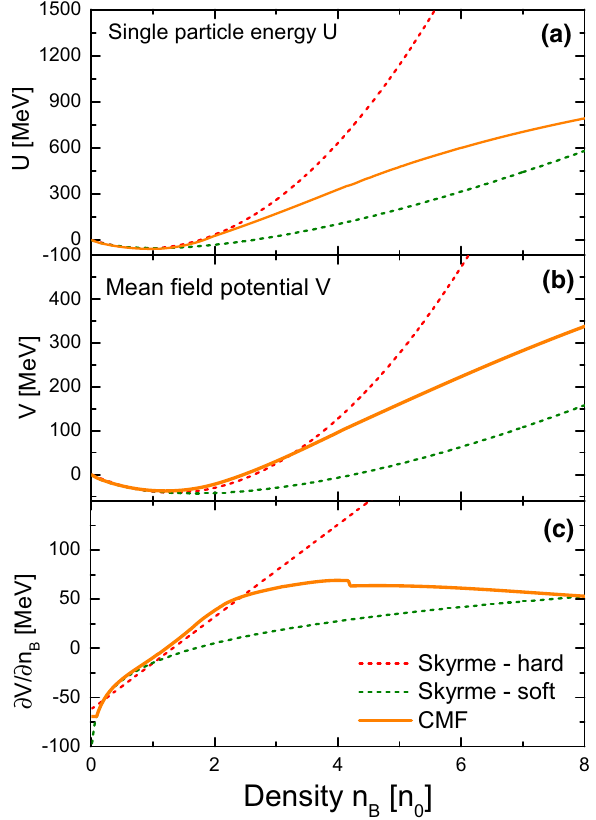
Fig. 2 a Nuclear potential V as a function of baryon density n B in units of the ground-state baryon density for three different potentials (resulting in a different equations of state). b The resulting field energy perbaryon E field / A forthethreedifferentequationsofstate. c Derivative of the field energy per nucleon with respect to the baryon density as a function of baryon density ρ B in units of the ground-state baryons density for three different potentials We show the Chiral mean field EoS (full orange line) in comparison to the well known hard Skyrme potential (dotted red line) and the soft Skyrme potential (dotted green